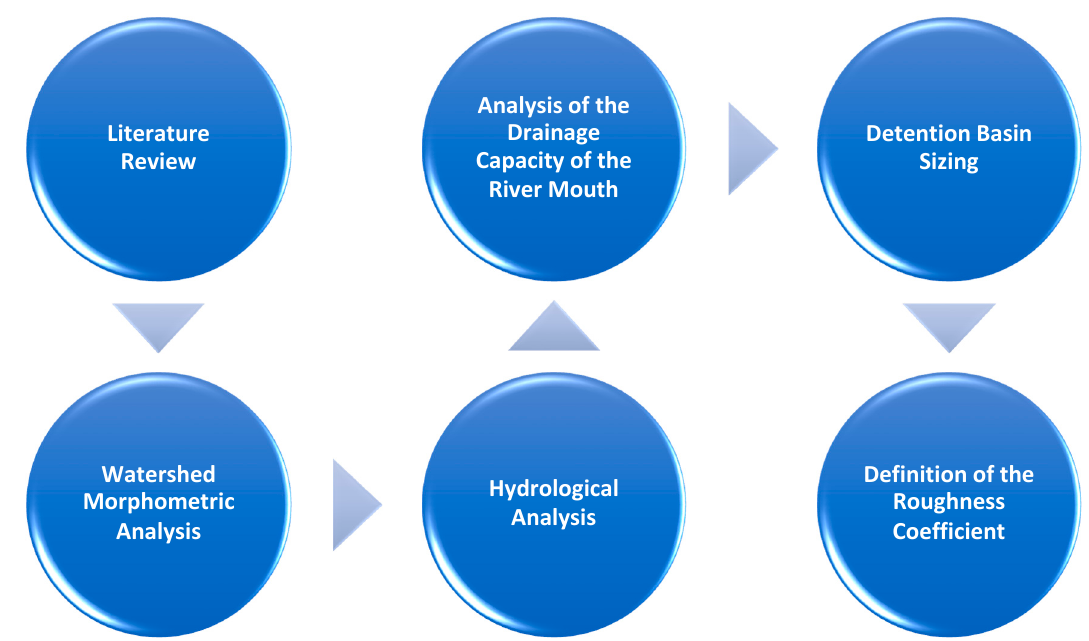
Figure 3. Organogram of the adopted methodology.